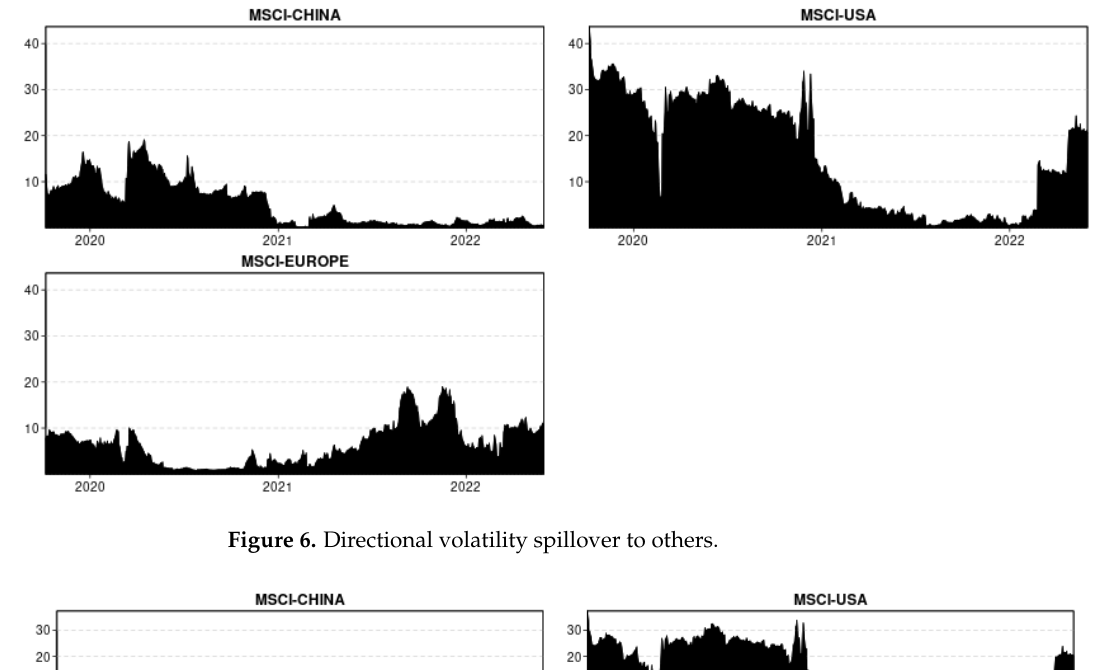
Figure 5. Directional volatility spillovers from others.